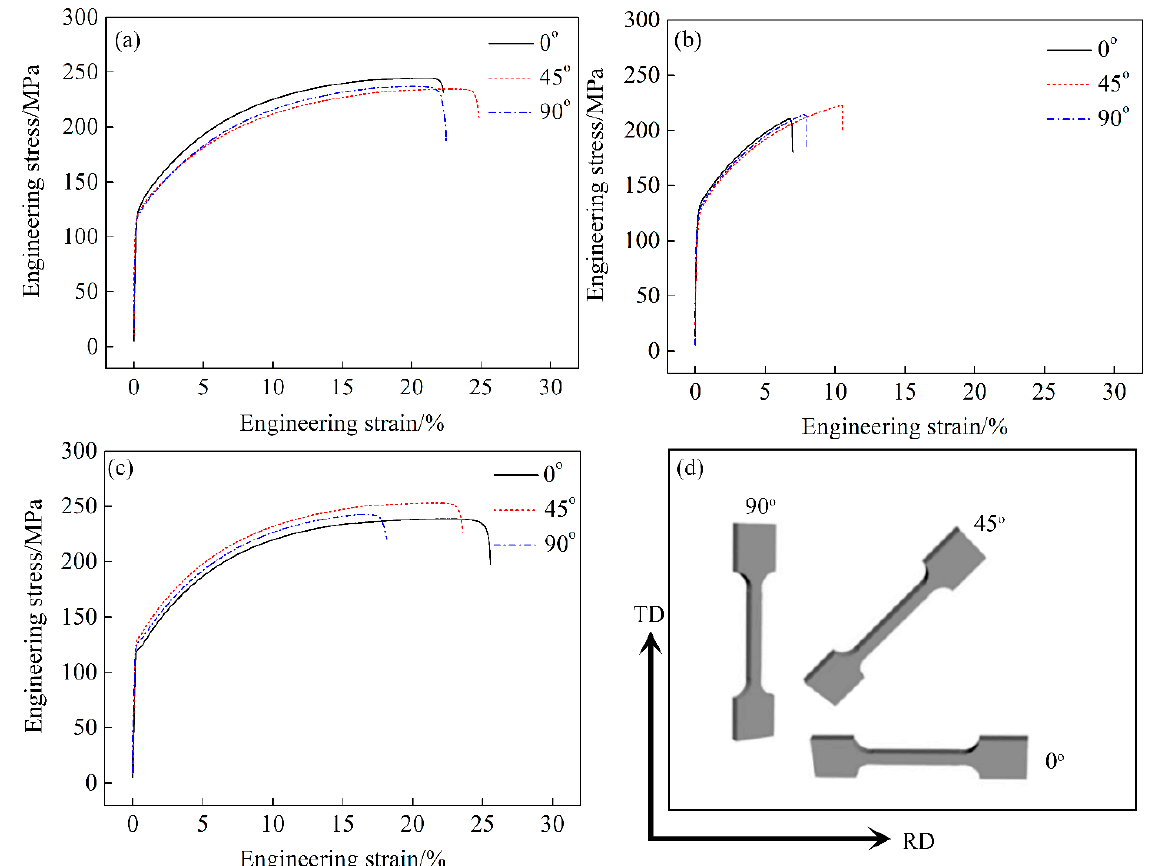
Figure 10. Engineering stress–strain curves of T4P-treated A1, A2 and A3 alloys in three directions: ( a ) A1 alloy, ( b ) A2 alloy, ( c ) A3 alloy, ( d ) Schematic diagram of the tensile direction.